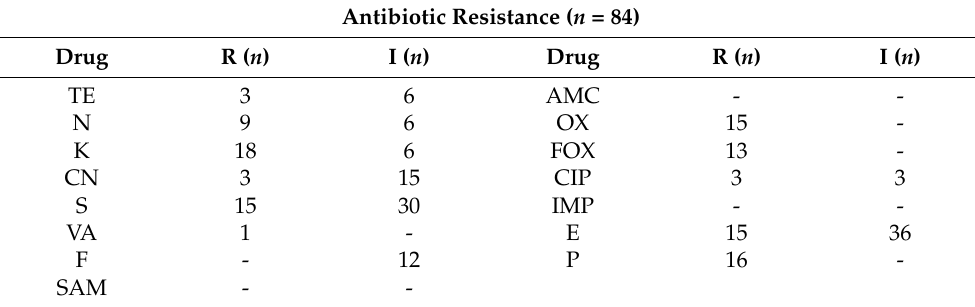
Figure 3. Staphylococcus spp. on CRA: ( A ) Strong slime-forming strain. ( B ) Non-producing slime. ( C ) Weak slime-forming strains. Table 1. Number of antibiotic-resistant isolates.